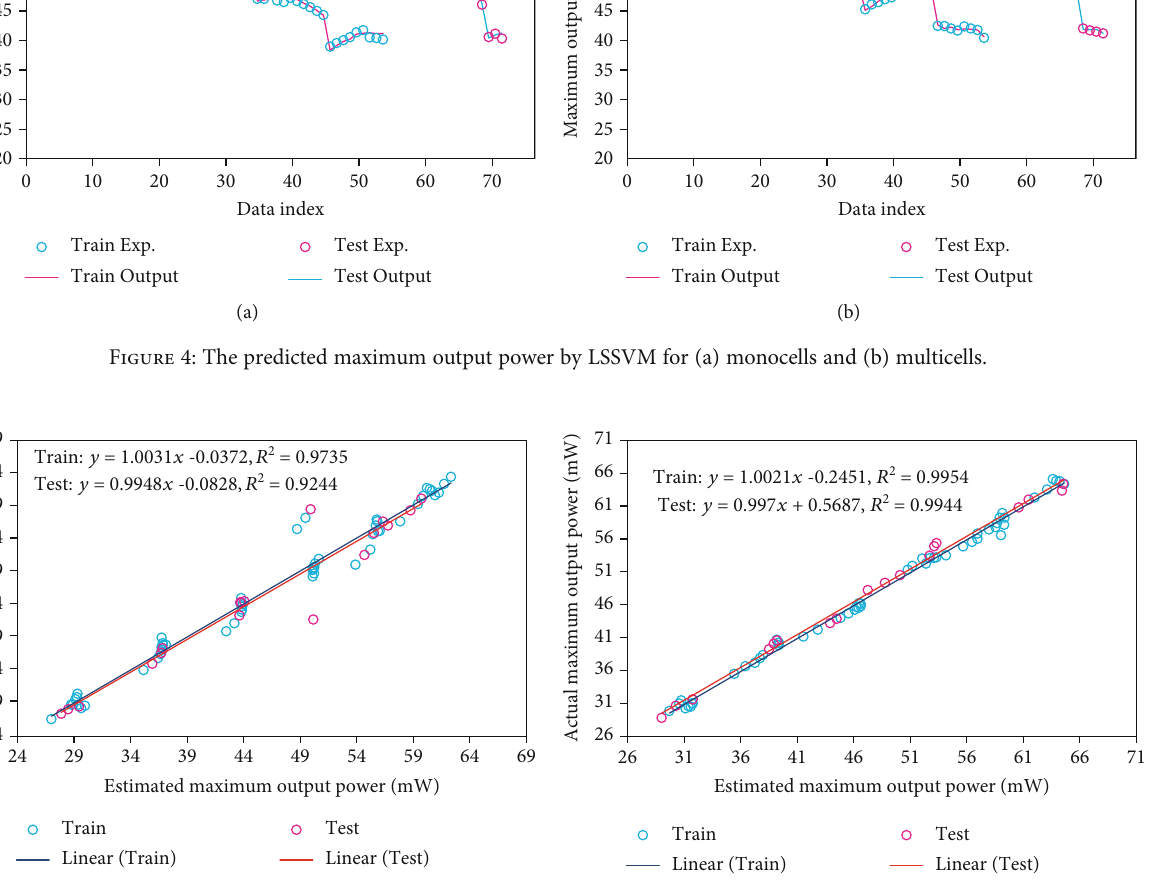
Figure 5: The cross plot of experimental and predicted maximum output power by ANFIS for (a) monocells and (b) multicells.